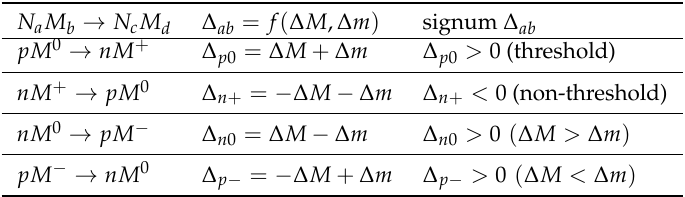
Table 1. The threshold parameters ∆ ab